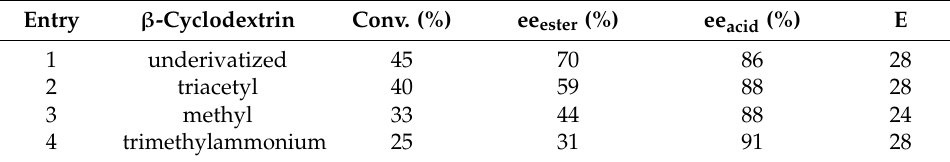
Table 4. Hydrolysis of 1e with PLE in the presence of β -cyclodextrins; conditions: [S] = 8